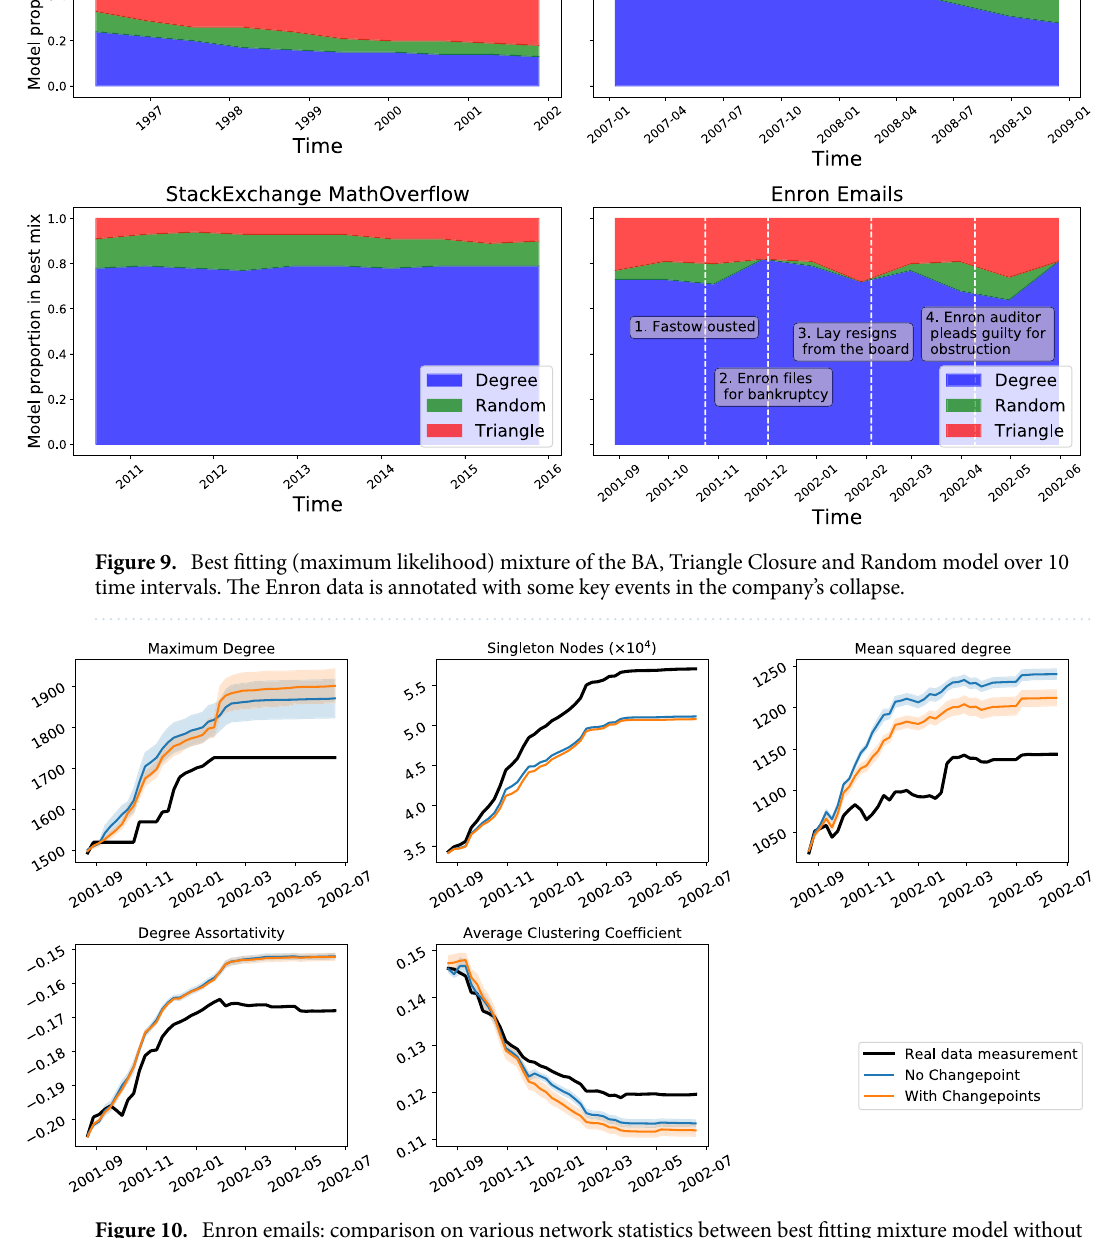
Figure 10. Enron emails: comparison on various network statistics between best fitting mixture model without change and its best fitting counterpart fitted over 10 equally sized intervals for the Enron emails